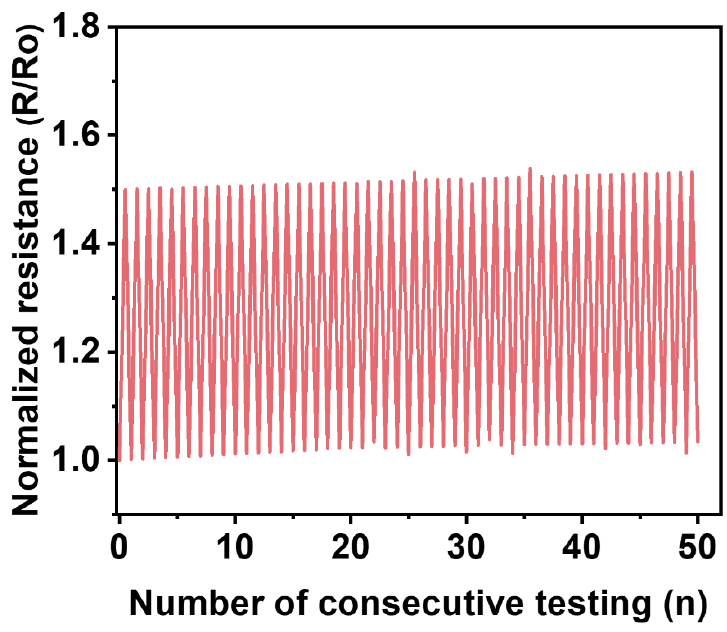
Figure 5. Normalized effective resistance of the liquid metal elastomer film with handwritten circuit during 50 consecutive cycles of tensile testing at strains of 100%.